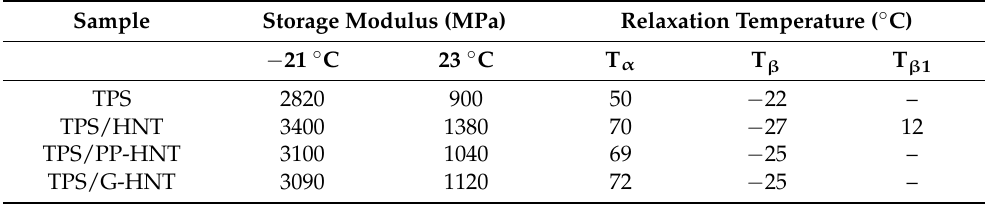
Table 3. Storage modulus and relaxation temperature of unmodified and halloysite-modified TPS.